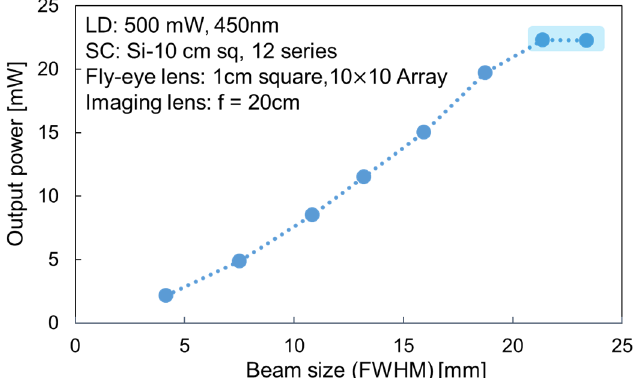
Figure 2. Beam size dependence of the output power.